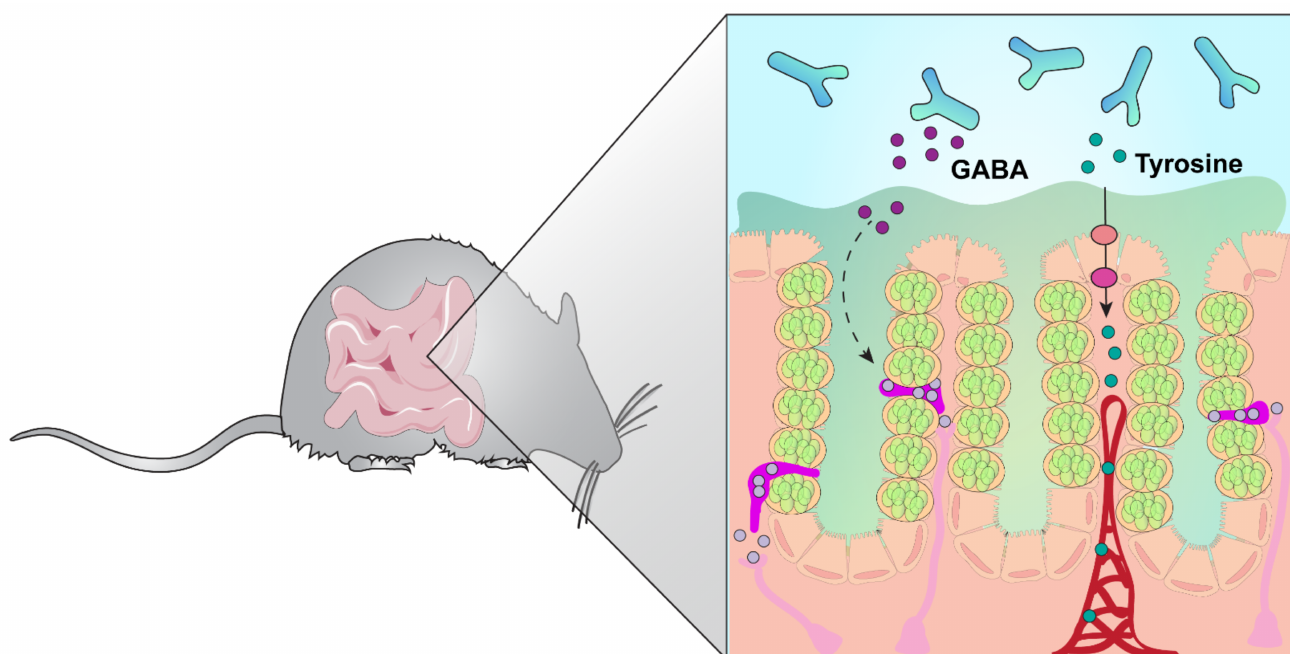
Figure 5. Model diagram of B. dentium colonization. Our data indicate that B. dentium can generate glutamine, GABA, and tyrosine. We speculate that GABA has a local effect on the enteroendocrine cells and enteric neurons in the gut, while tyrosine can be transported through the epithelium, enter the circulation, and be transported into the